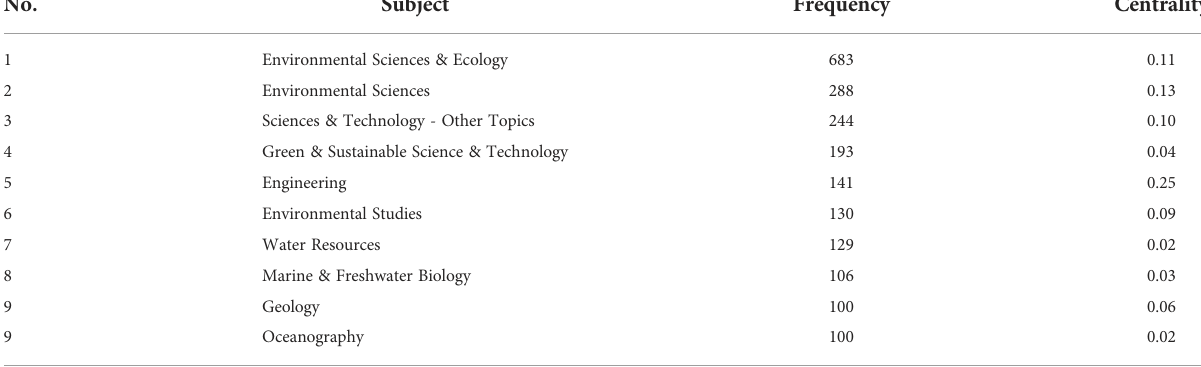
TABLE 3 The top 10 topic categories based on frequency.